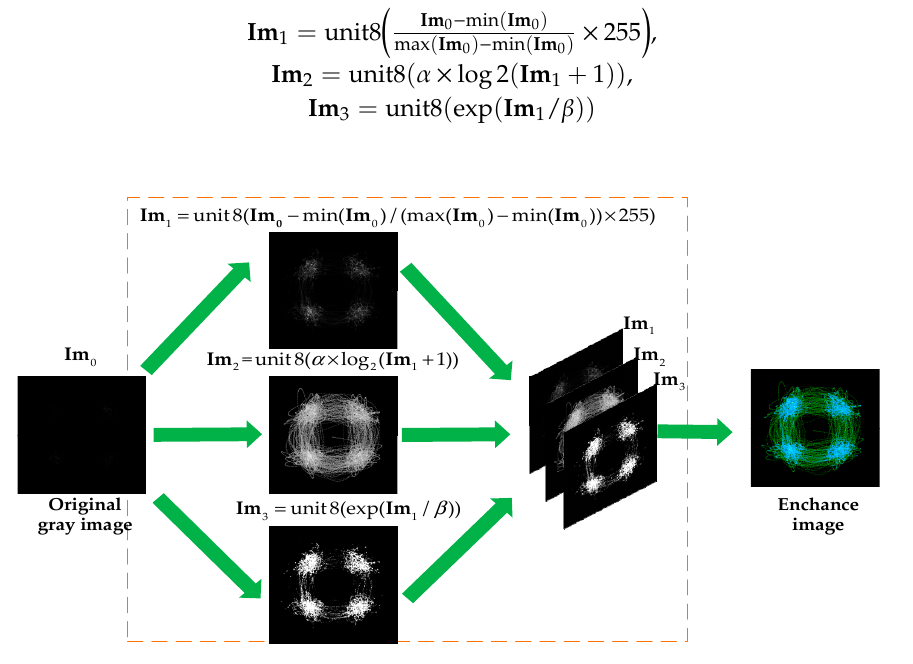
Figure 4. The enhancement processing of the Figure 4. the enhancement processing of the dataset.